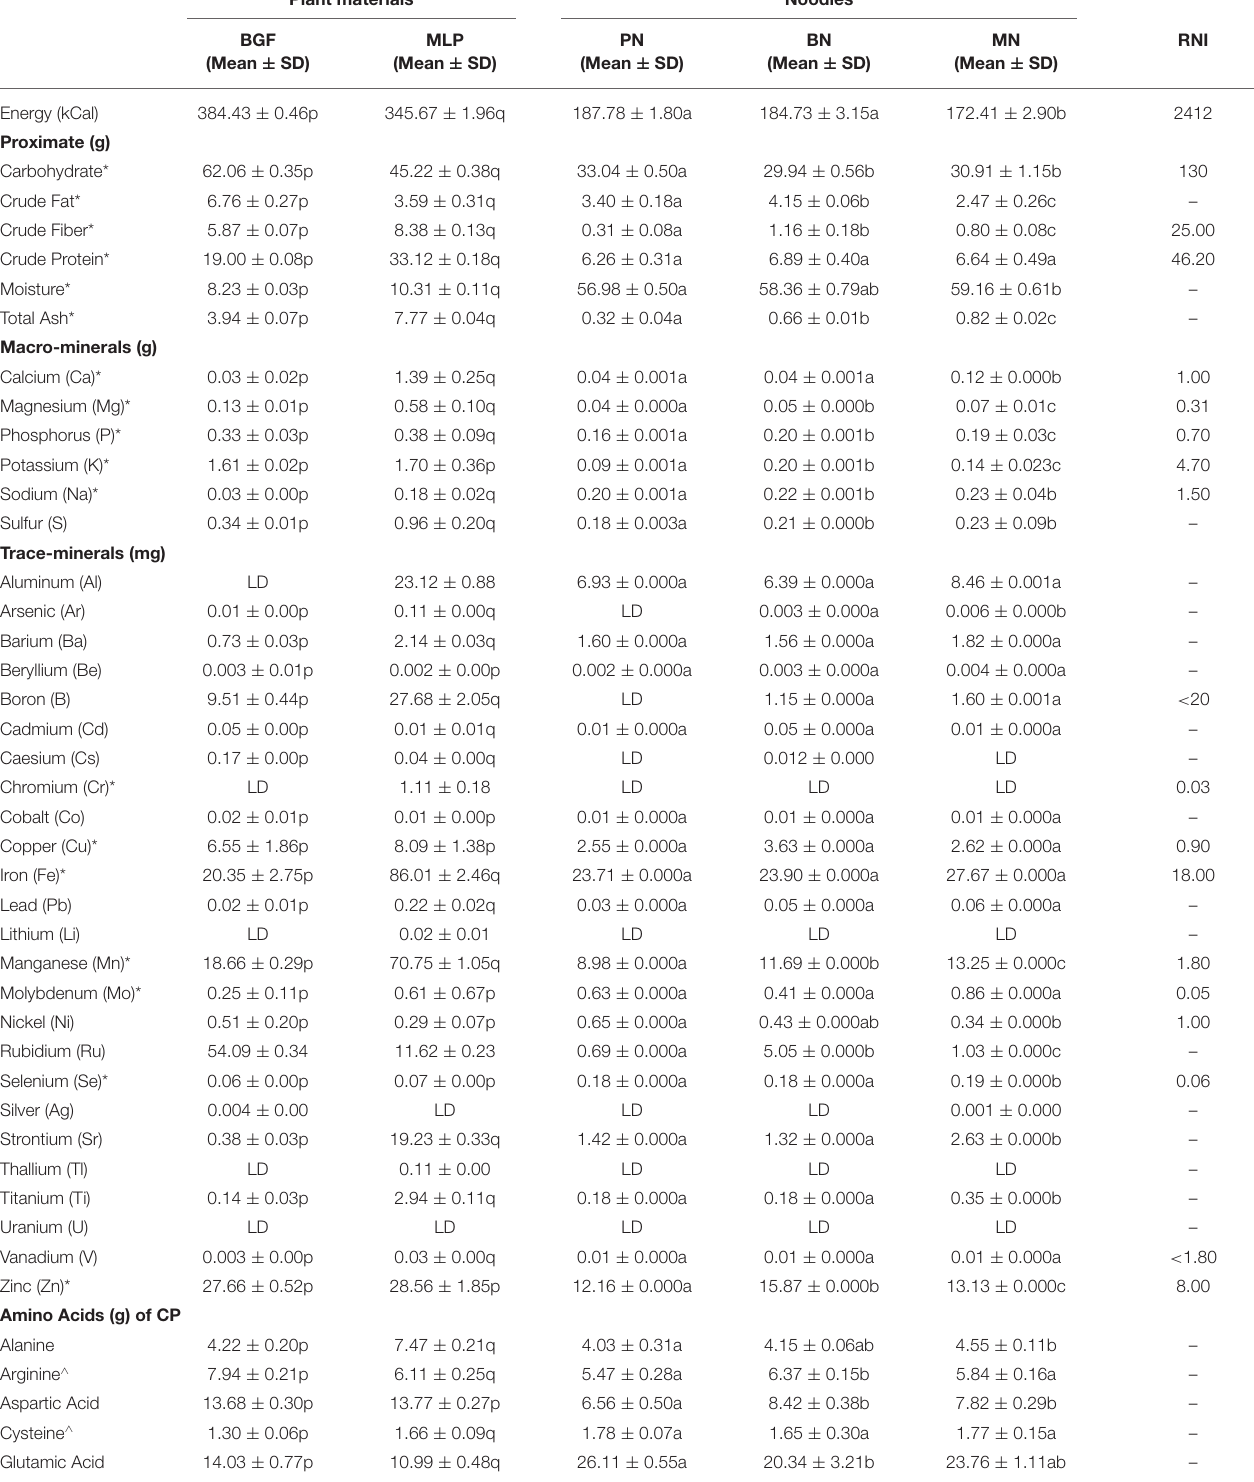
TABLE 2 | Nutritional composition of BGF, MLP, PN, BN and